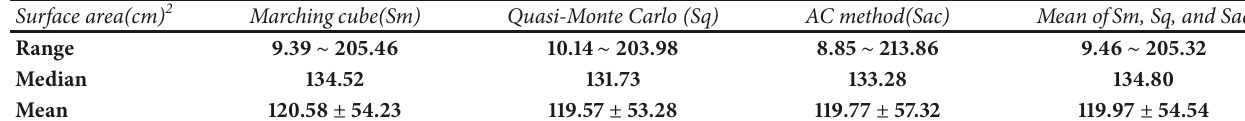
Table 1: Surface area results obtained using different methods.